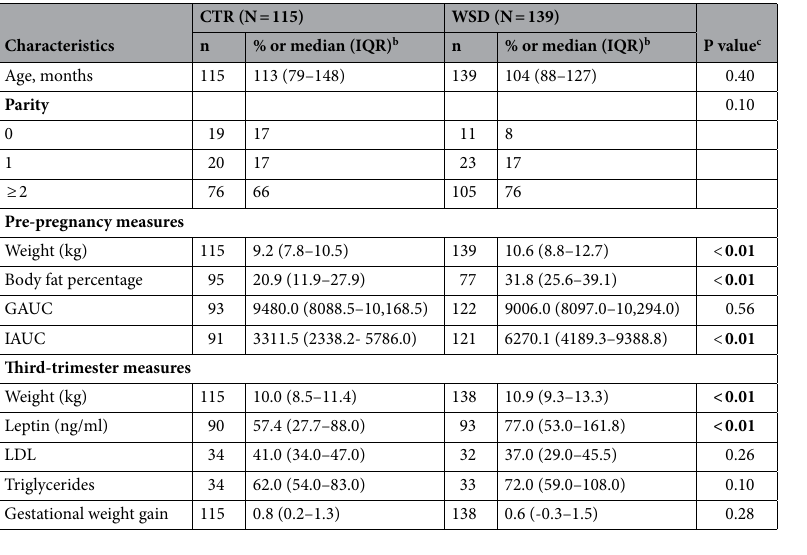
Table 1. Distribution of maternal characteristics stratified by diet (n = 254) a . WSD, western-style diet; CTR, control diet; IQR, interquartile range; AU, arbitrary units; GAUC, glucose tolerance test area under the curve; IAUC, insulin area under the curve; LDL, low-density lipoproteins. a Nineteen pregnancies on control diet were excluded for this table due to their diet history (they were placed on control diet after being exposed to WSD in one or more prior pregnancies). b Median and IQR are reported for continuous variables due to small sample size and skewness; percent is reported for parity. c From Wilcoxon rank-sum test for continuous measures; Pearson chi-squared test for parity. d Parity refers to number of live births prior to study pregnancy. The bold indicates significantly different values from the reference group.